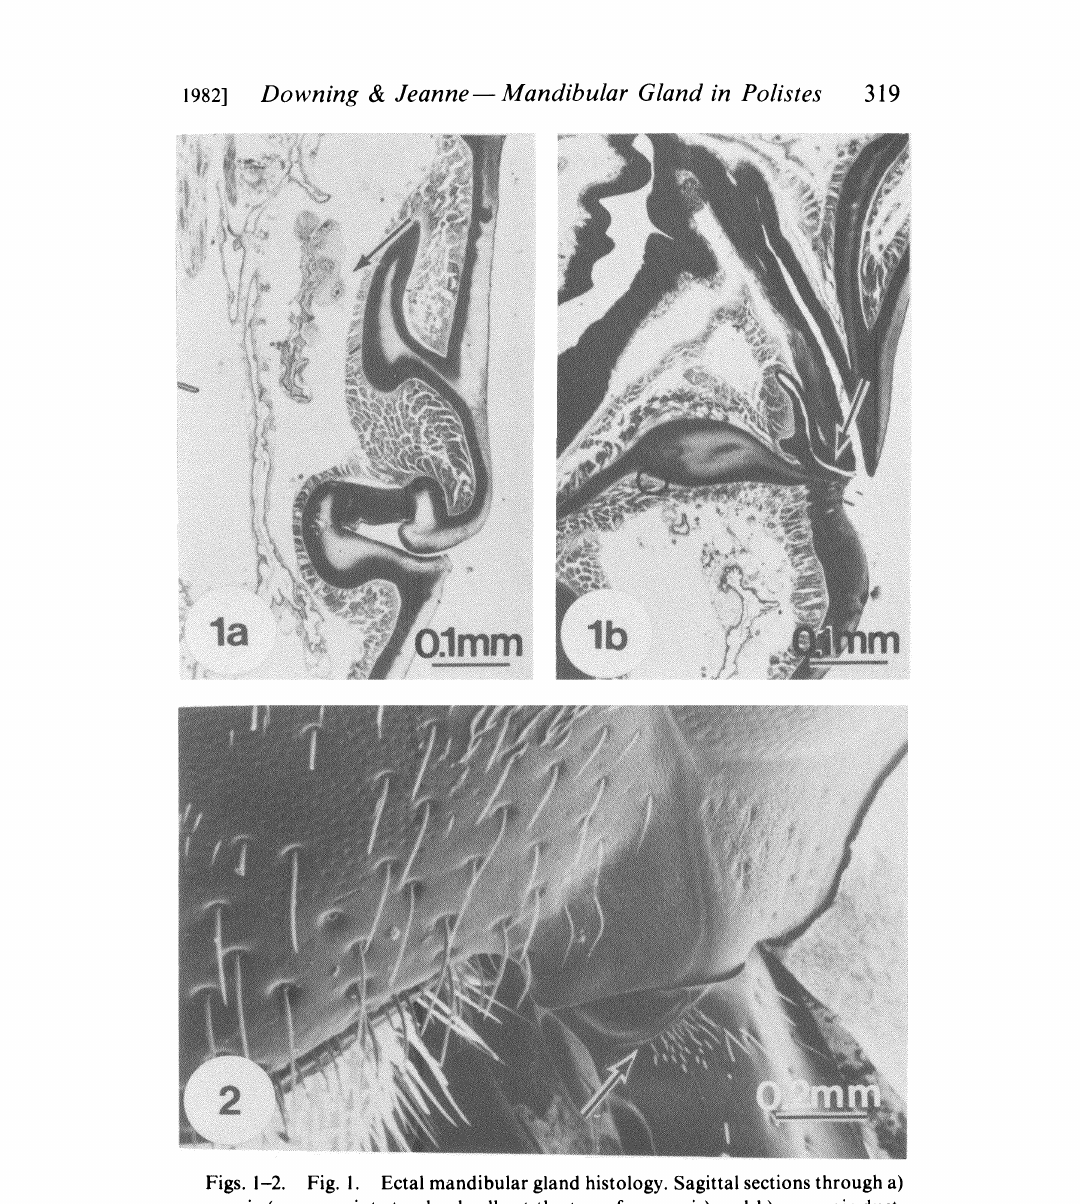
Figs. 1-2. Fig. 1. Ectal mandibular gland histology. Sagittal sections through a) reservoir (arrow points to gland cells at the top of reservoir) and b) reservoir duct, showing duct opening to the mandibular brush (arrow). Anterior is to the right. Fig. 2. Ectal mandibular gland opening, frontal view. SEM micrograph of the exposed mandibular brush, located just below the opening of the ectal mandibular gland (arrow). The mandible is in an open position. Clypeus is on the left, compound eye in the upper